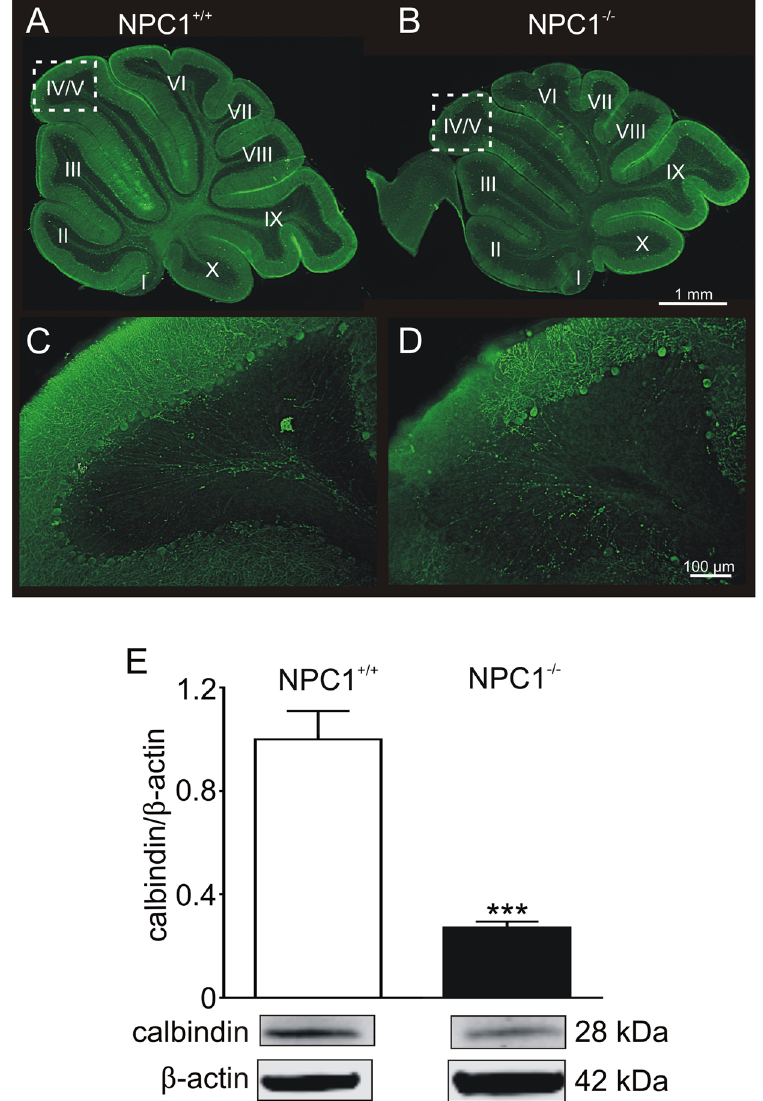
Figure 1. Purkinje cell degeneration in p55 NPC1 − / − mice NPC1 + / + mice. ( A ) show an even distribution of calbindin positive PCs in contrast to NPC1 − / − mice ( B ). A higher magnification of lobe IV/V of NPC1 + / + ( C ) and NPC1 − / − mice ( D ) demonstrates the loss of Purkinje cell somata in NPC1 − / − mice. ( E ) Western blot analysis confirmed a reduced number of PCs by a significantly decreased protein level of calbindin (NPC1 + / + : N = 8, n = 25; NPC1 − / − : N = 8, n = 23). Western blot bands display corresponding examples of the same gel. *** p < 0.001, data shown as mean ± sem. Student´s unpaired t-test was used to determine